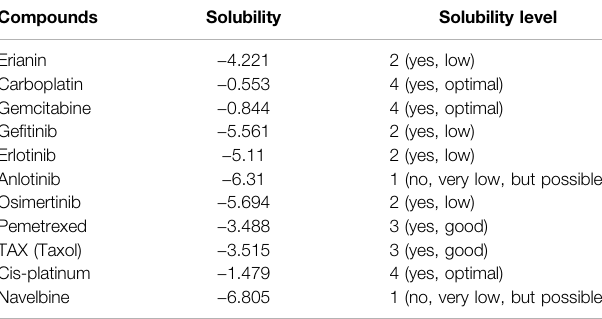
TABLE 3 | Aqueous solubility prediction of erianin and reference drugs. Compounds Solubility Solubility level Erianin